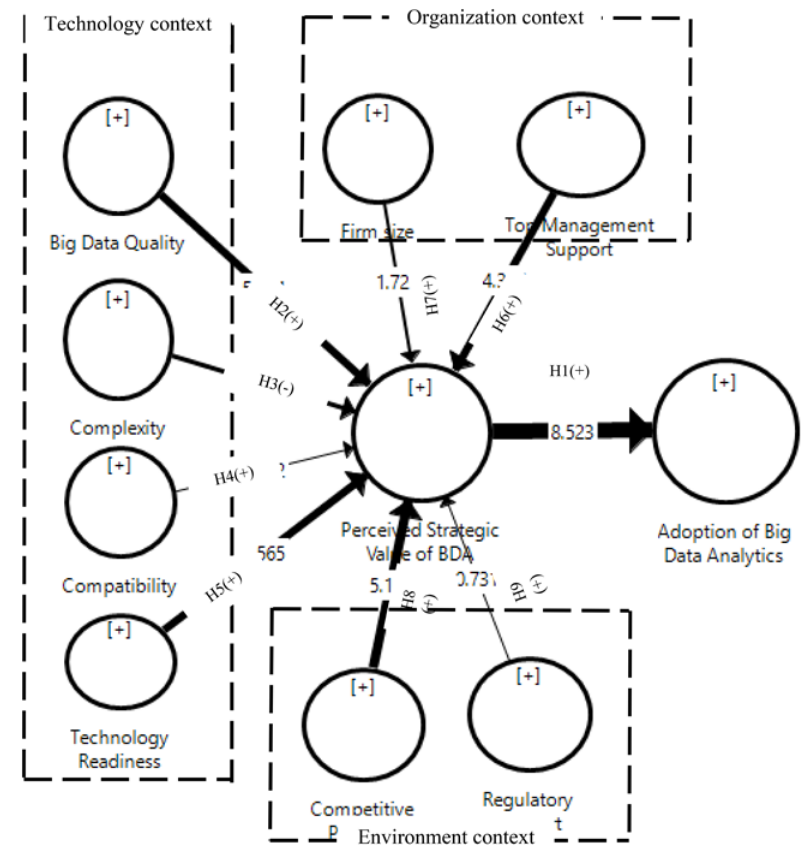
Model testing for Full